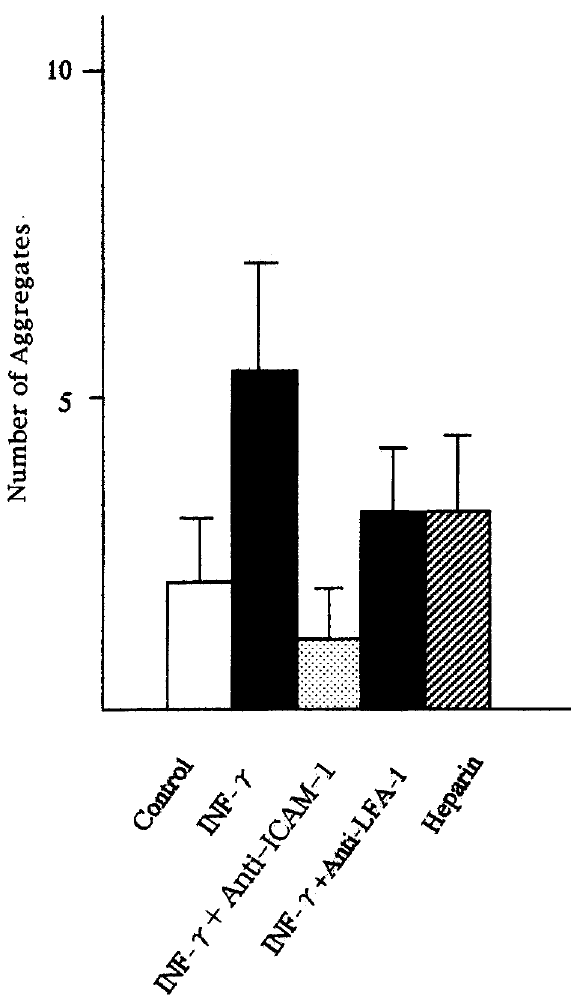
FIG. 6. Effect of INF- g , INF- g + Anti-ICAM-1Ab, INF- g + Anti- LFA-1Ab and heparin on AM aggregation in vitro . Data are presented as the mean ±SEM of the number of cells comprising each